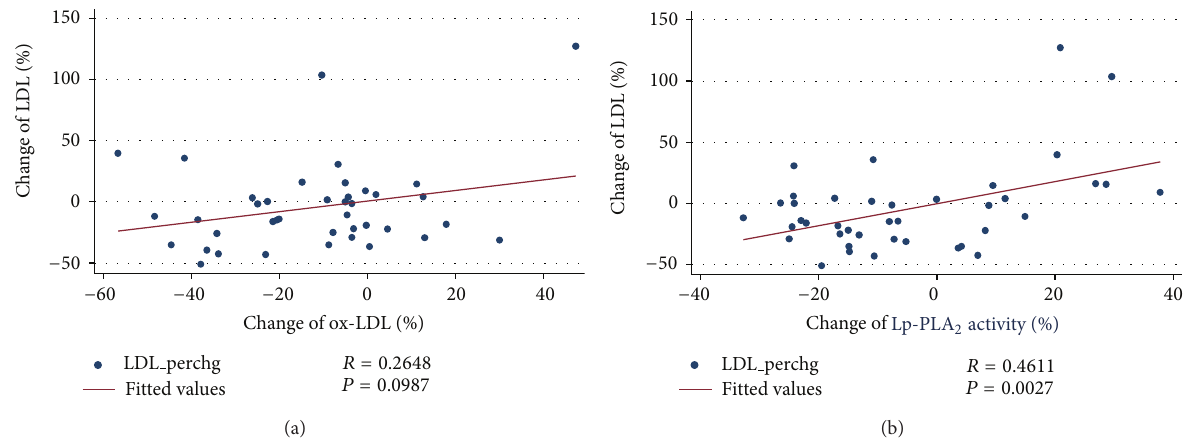
Figure 5: Percent change of LDL-C following rapid weight loss among obese men and women with the metabolic syndrome versus percent change of (a) ox-LDL and (b) Lp-PLA 2 activity, Pearson’s correlation.